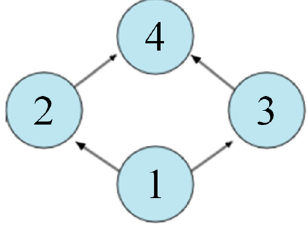
Figure 1. A DAG example.